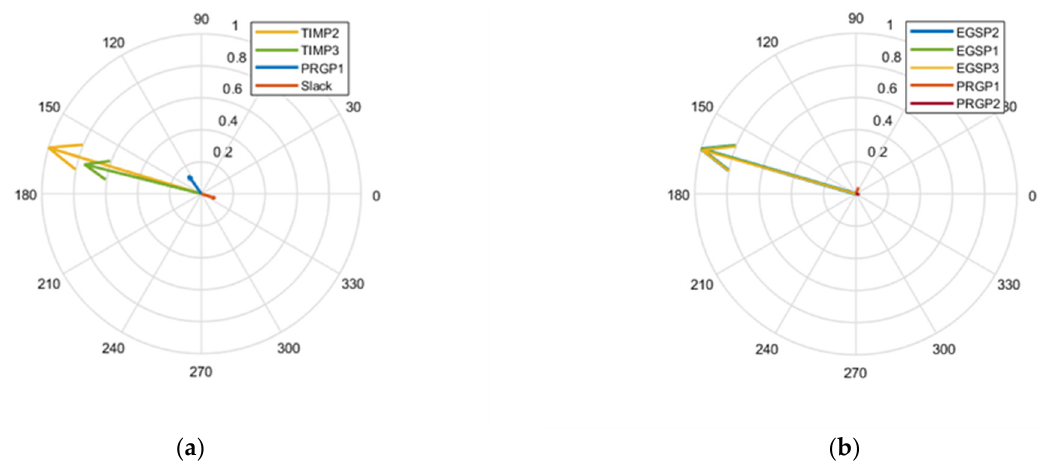
Figure 12. High Import DP: ( a ) oscillation vector of mode M1; ( b ) oscillation vector of mode M2. Modes M3 and M4 are both intra-plant modes concerning the units of EGSP with the same frequency, 1.59 Hz, and a damping factor of 8.83% and 8.90%, respectively. Their oscillation vectors are shown in Figure 13a,b, respectively. In mode M3, EGSP3 oscillates against EGSP1 and EGSP2, while in mode M4, EGSP1 oscillates against EGSP2 and EGSP3.